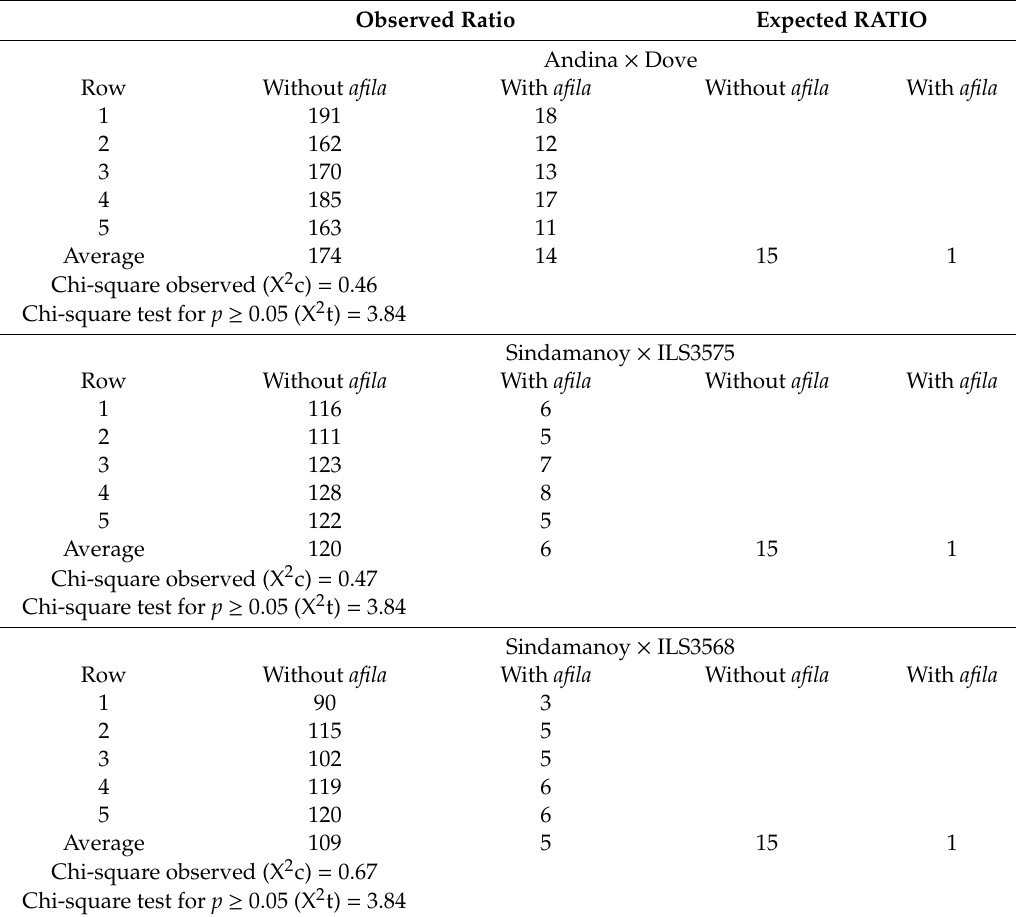
Table 2. Observed and expected segregation ratios and chi-square tests for numbered of plants with and without the expression of the homozygous recessive afila gene in the BC 2 F 2 populations from the backcrosses made with the abbreviated selection method for three climbing × bush garden pea crosses. Observed Ratio Expected RATIO Andina × Dove Without afila With afila Without afila With afila